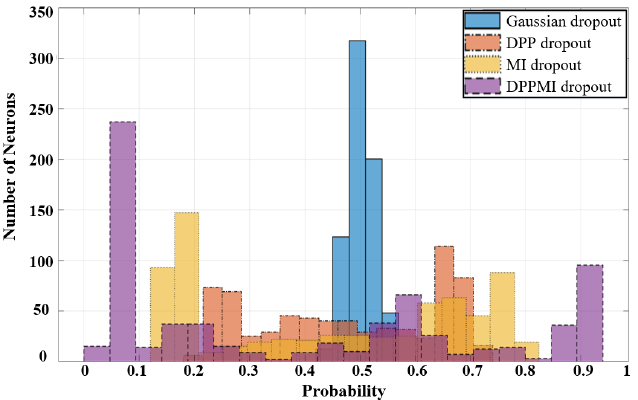
Figure 8. Assigned probabilities to neurons on different